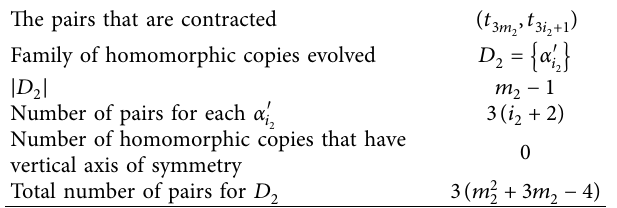
Table 2: Necessary information regarding homomorphic copies